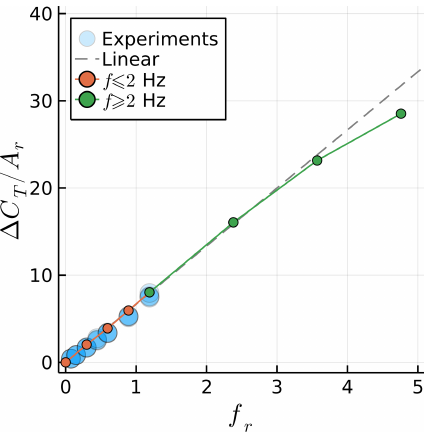
Figure 9. Maximum surge velocity effect on the amplitude of the fluctuation in the thrust coefficient.